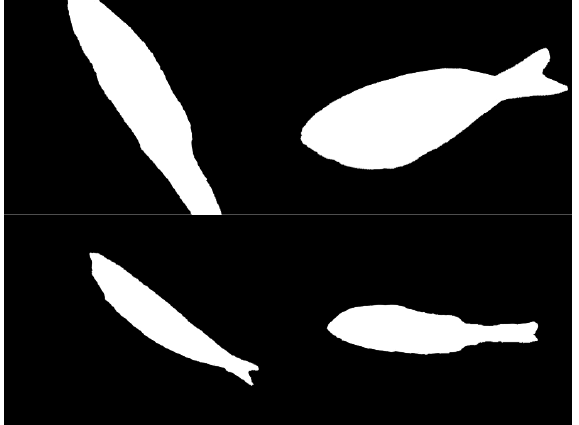
Figure 12. The segmentation results of